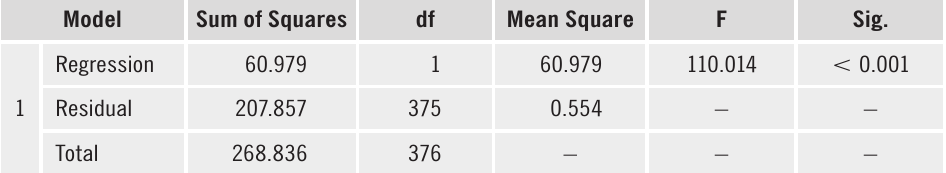
Table 13. Anova: level of market orientation and competitiveness index Model Sum of Squares df Mean Square F Sig.